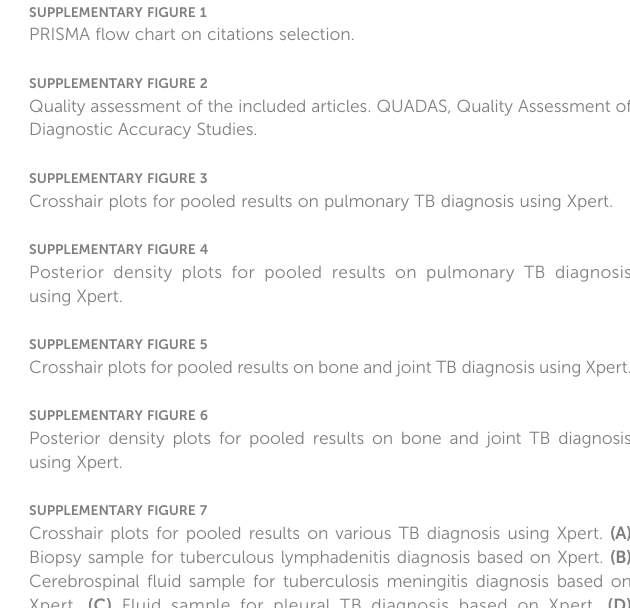
SUPPLEMENTARY TABLE 1 Essential information of included studies. SUPPLEMENTARY TABLE 2 Traf fi c light plot (A) for the assessment of potential risk of bias summary, which have 5 columns (D1 for Patient selection, D2 for Index test, D3 for Reference standard, D4 for Flow and time, and 1 for overall judgements, in that order). SUPPLEMENTARY FIGURE 1 PRISMA fl ow chart on citations selection. SUPPLEMENTARY FIGURE 2 Quality assessment of the included articles. QUADAS, Quality Assessment of Diagnostic Accuracy Studies. SUPPLEMENTARY FIGURE 3 Crosshair plots for pooled results on pulmonary TB diagnosis using Xpert. SUPPLEMENTARY FIGURE 4 Posterior density plots for pooled results on pulmonary TB diagnosis using Xpert. SUPPLEMENTARY FIGURE 5 Crosshair plots for pooled results on bone and joint TB diagnosis using Xpert. SUPPLEMENTARY FIGURE 6 Posterior density plots for pooled results on bone and joint TB diagnosis using Xpert. SUPPLEMENTARY FIGURE 7 Crosshair plots for pooled results on various TB diagnosis using Xpert. (A) Biopsy sample for tuberculous lymphadenitis diagnosis based on Xpert. (B) Cerebrospinal fl uid sample for tuberculosis meningitis diagnosis based on Xpert. (C) Fluid sample for pleural TB diagnosis based on Xpert. (D) Extrapulmonary TB diagnosis based on Xpert. (E) Ascitic fl uid for peritoneal TB diagnosis based on Xpert. SUPPLEMENTARY FIGURE 8 Posterior density plots for pooled results on various TB diagnosis using Xpert. (A) Biopsysample fortuberculouslymphadenitis diagnosisbased onXpert. (B) Cerebrospinal fl uid sample for tuberculosis meningitis diagnosis based on Xpert. (C) Fluid sample for pleural TB diagnosis based on Xpert. (D) Extrapulmonary TB diagnosis based on Xpert. (E) Ascitic fl uid for peritoneal TB diagnosis based on